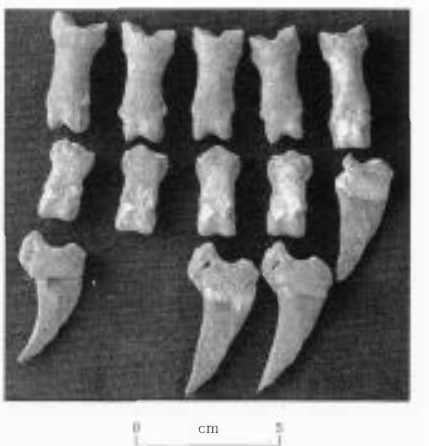
Figure 7 Bones of a bear paw, found in articulation in the South area at (:atal­